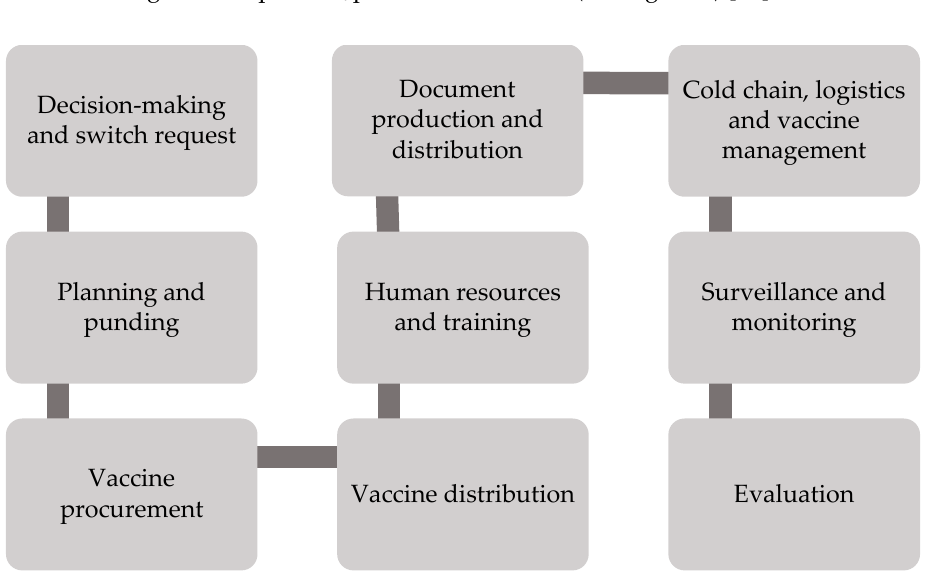
Figure 3. Planning guidance on product/presentation switch activity.